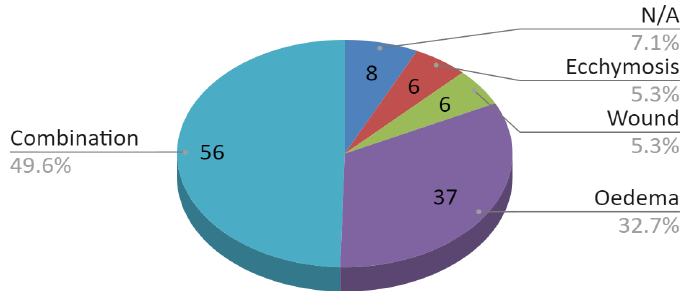
Figure 8. Coexisting soft tissue injuries.